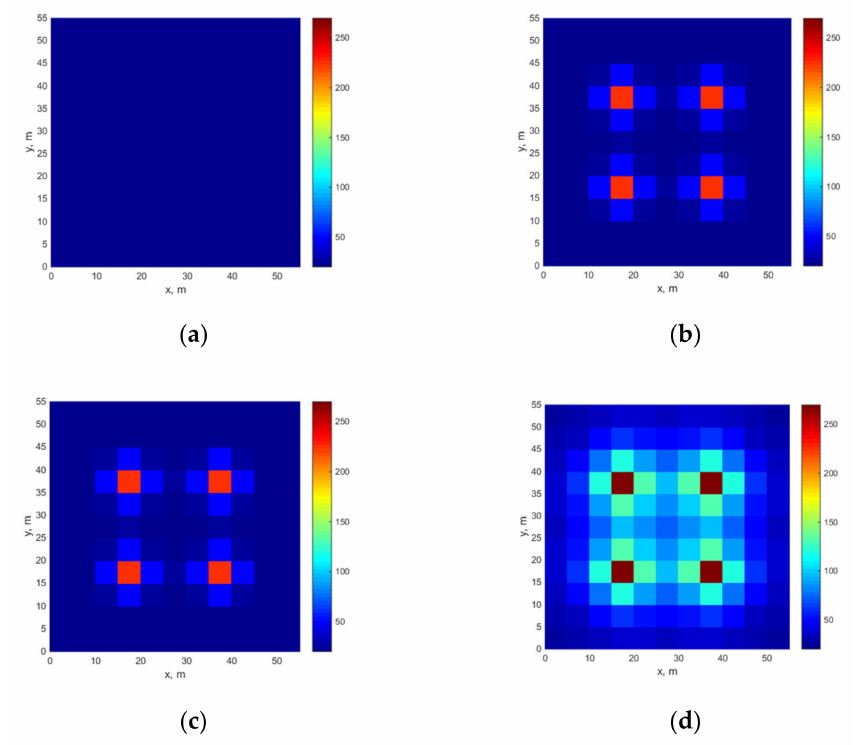
Figure 5. Reservoir temperature profiles calculated by this method. ( a ) The 0.001th day; ( b ) the 10th day; ( c ) the 30th day; ( d ) the 200th day.